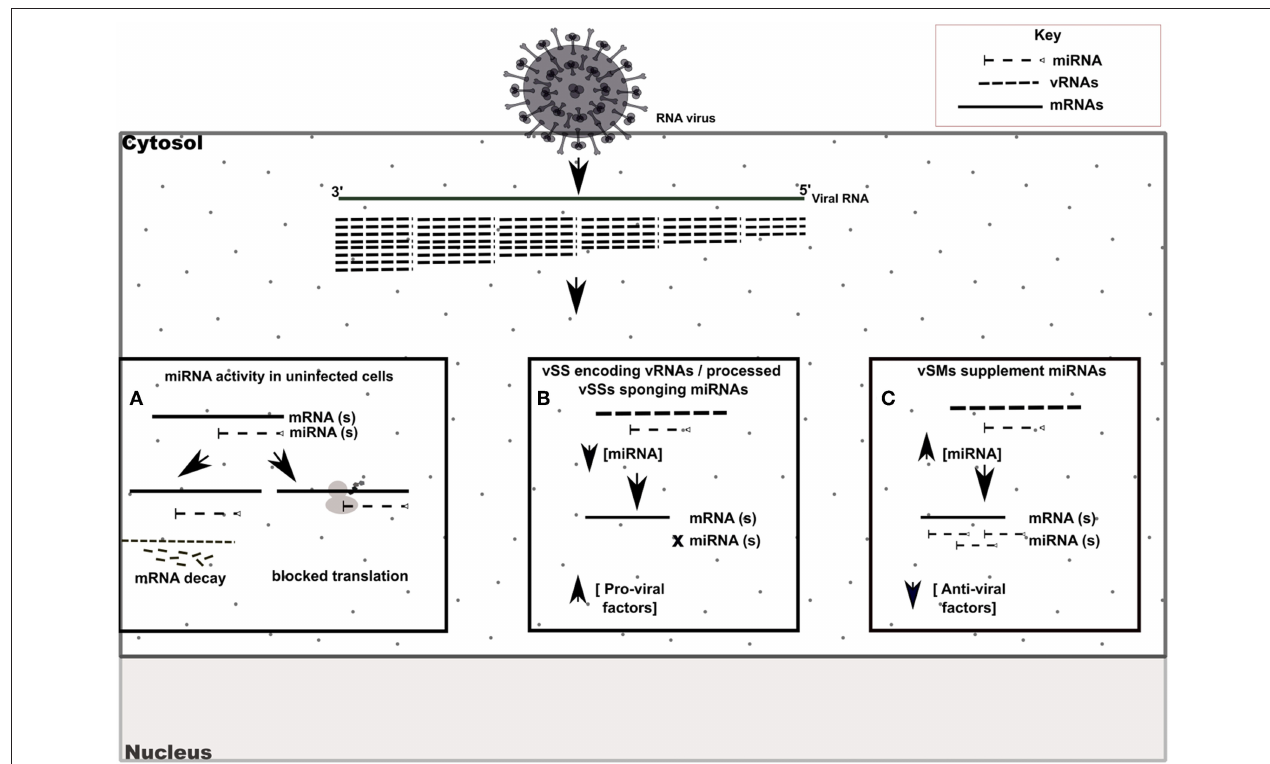
FIGURE 6 | Model of vSM / vSS modulation of host responses during infection. Host mRNA are depicted as solid lines, microRNAs are depicted as dashed lines with end caps while viral transcripts are depicted as dashed lines. (A) Normal post-transcriptional miRNA regulation of gene expression. Degree of miRNA complementarity determines if gene knockdown proceeds via mRNA decay/translation following miRNA binding to target transcript in the RISC complex. (B) Viral RNAs encoding vSSs/processed vSSs bind to host miRNAs and prevent native suppression of pro-viral factors. (C) Viral RNAs encoding vSMs can supplement host miRNA activity and suppress anti-viral